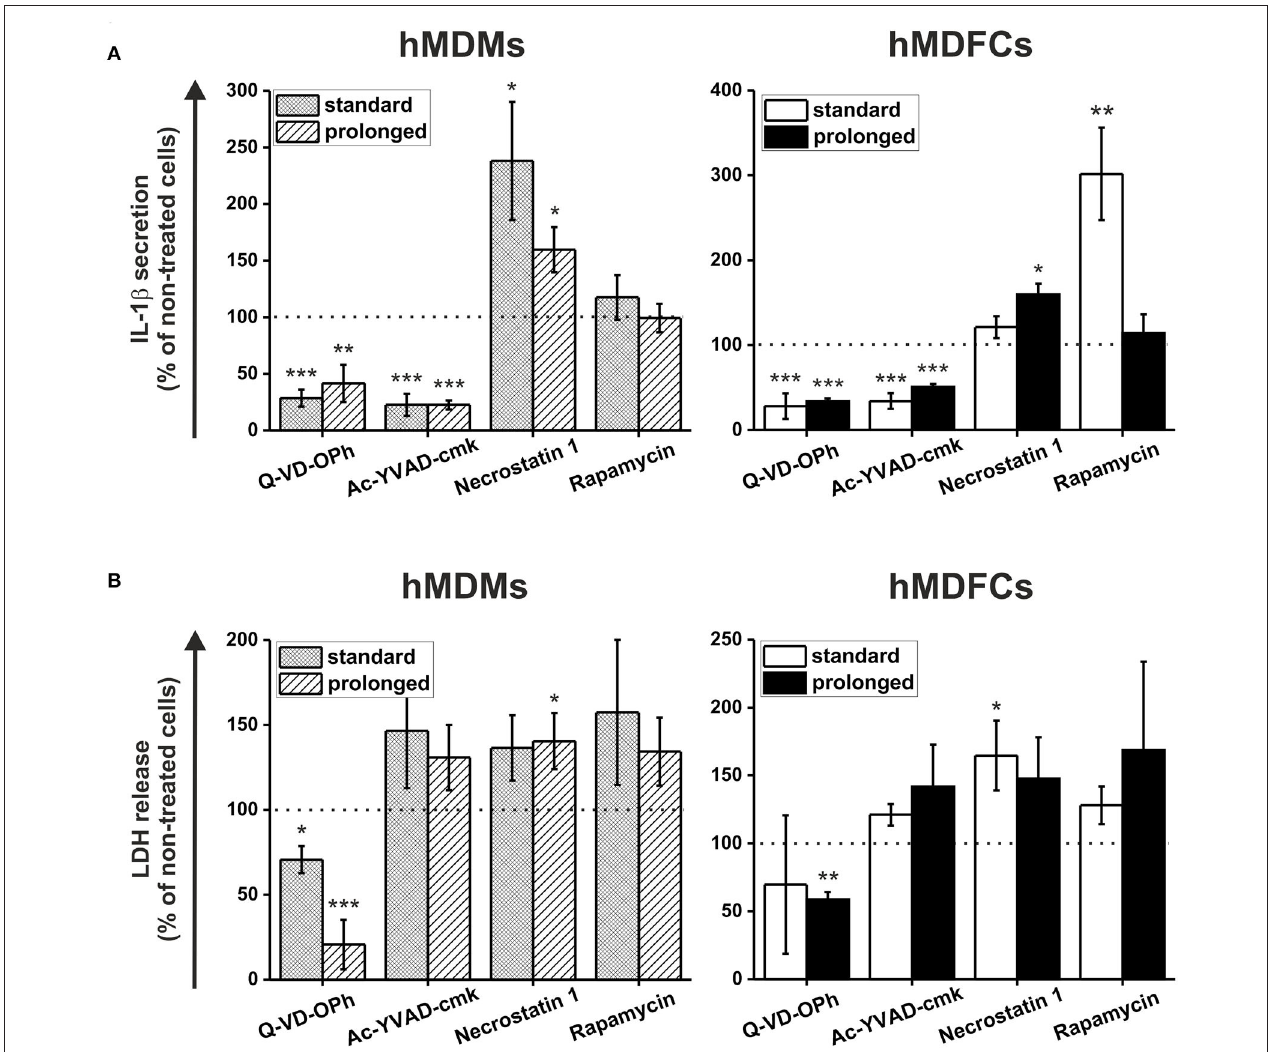
FIGURE 8 | The effect of caspases, RIP1 kinase and mTOR inhibition on pyroptosis and IL-1 β secretion by hMDFCs obtained by standard and prolonged cell culture. Standard/prolonged-hMDMs/hMDFCs were obtained as indicated in Materials and Methods, and Figure 1 . Cells were primed with stLPS (1 µ g/mL) for 4h and then stimulated with nigericin (10 µ M) for 20h with or without caspase inhibitors (Q-VD-OPh or Ac-YVAD-cmk), RIP1 kinase inhibitor (necrostatin-1) or mTOR inhibitor (rapamycin) pretreatment as described in Materials and Methods. Levels of IL-1 β (A) and LDH (B) in supernatants were determined by ELISA and Pierce TM LDH Cytotoxicity Assay Kit, respectively. Results were expressed as a percent of IL-1 β secretion and LDH release by cells stimulated without inhibitors—non-treated cells (100% indicated with dashed horizontal lines). Bars and error bars represent means ± SEM from four (Q-VD-OPh) or five (others) independent experiments (each in duplicate, n ≥ 8). * p < 0.05, ** p < 0.01, *** p < 0.001 vs. non-treated cells. Raw data of IL-1 β production and LDH release were shown in Supplementary Figure 3